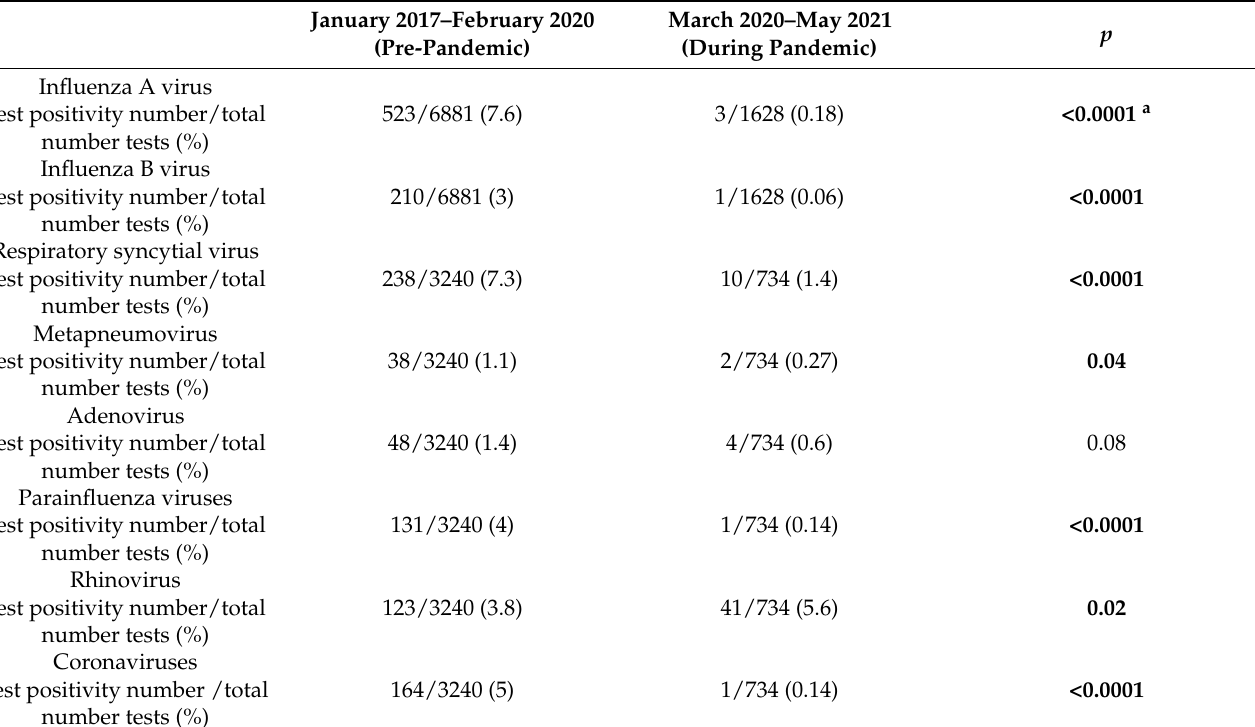
Table 2. Comparison of positivity rates of respiratory viruses other than SARS-CoV-2 between January 2017–February